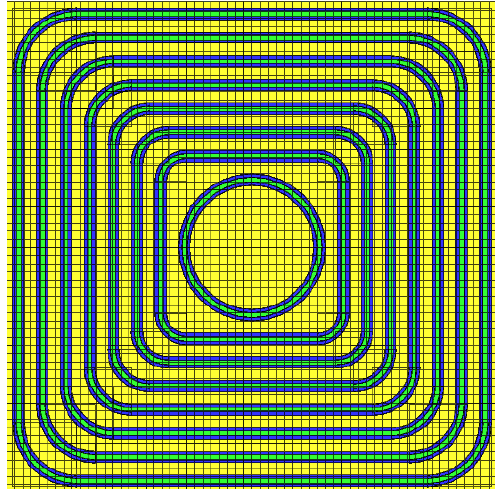
Figure 1. Top view of 8-tube IRT-4M fuel assembly (yellow – water coolant, blue – cladding layer, green – fuel layer).